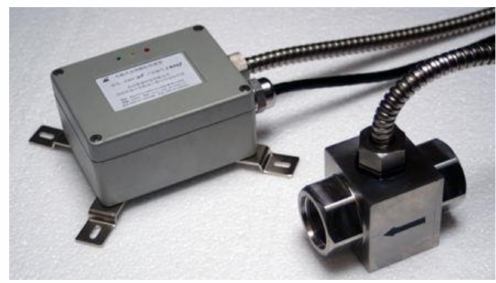
Figure 3. The ZCMS type of metal debris